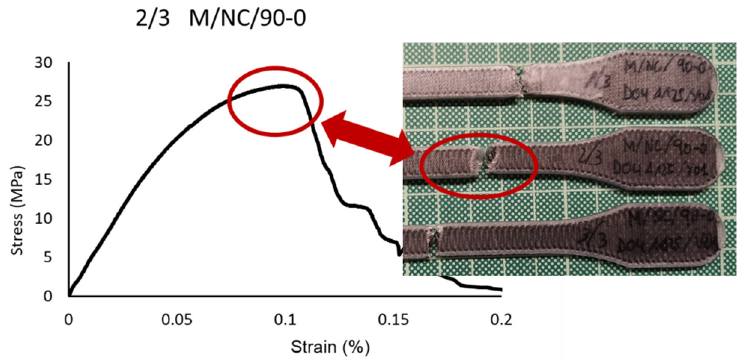
Figure 24. Breakage detail of 1/3 M/NC/90-0 and stress-strain graph.